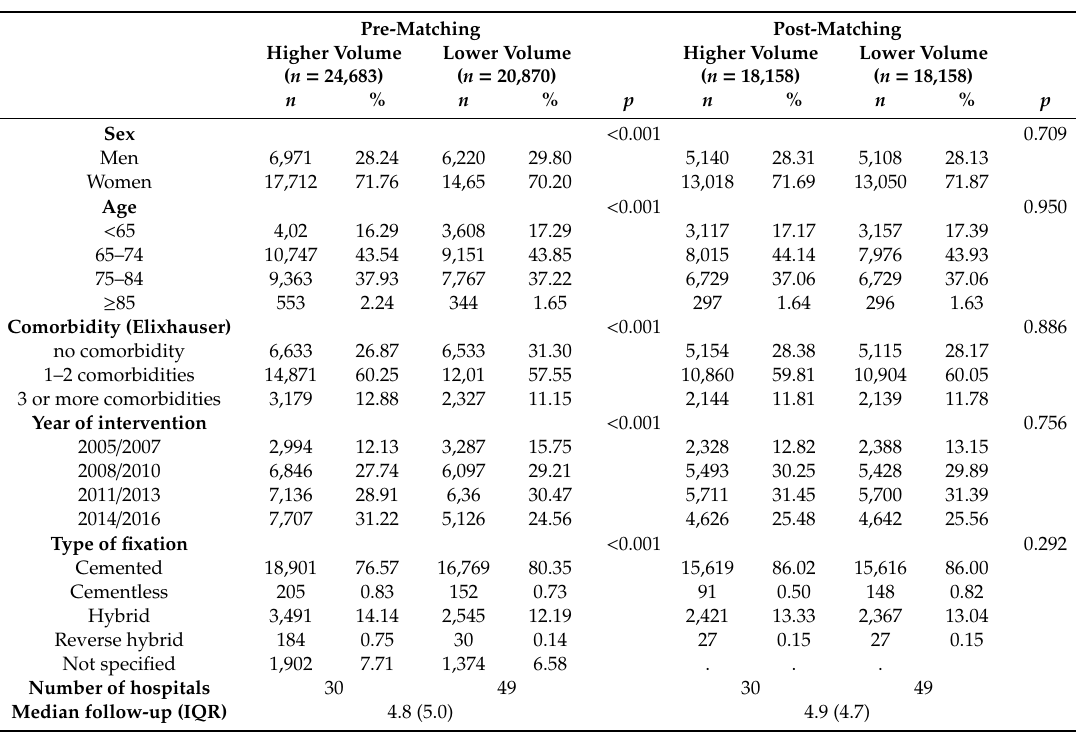
Table 2. Characteristics of the total knee arthroplasty study population prior to and after matching. RACat